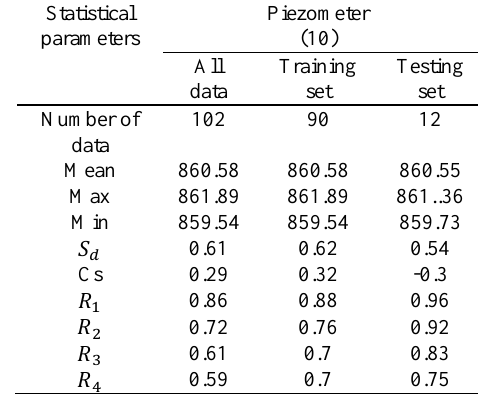
Table 5. Statistics analysis for training, testing and all data